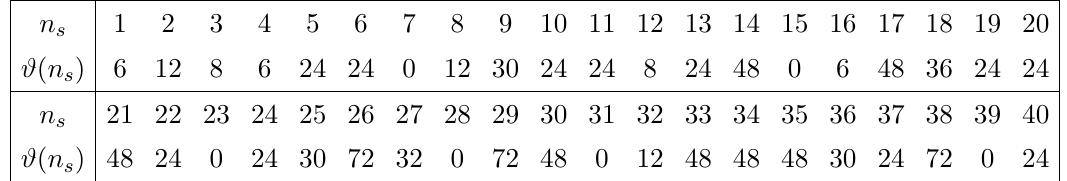
Table 1 . The values of multiplicity up to n s = 40